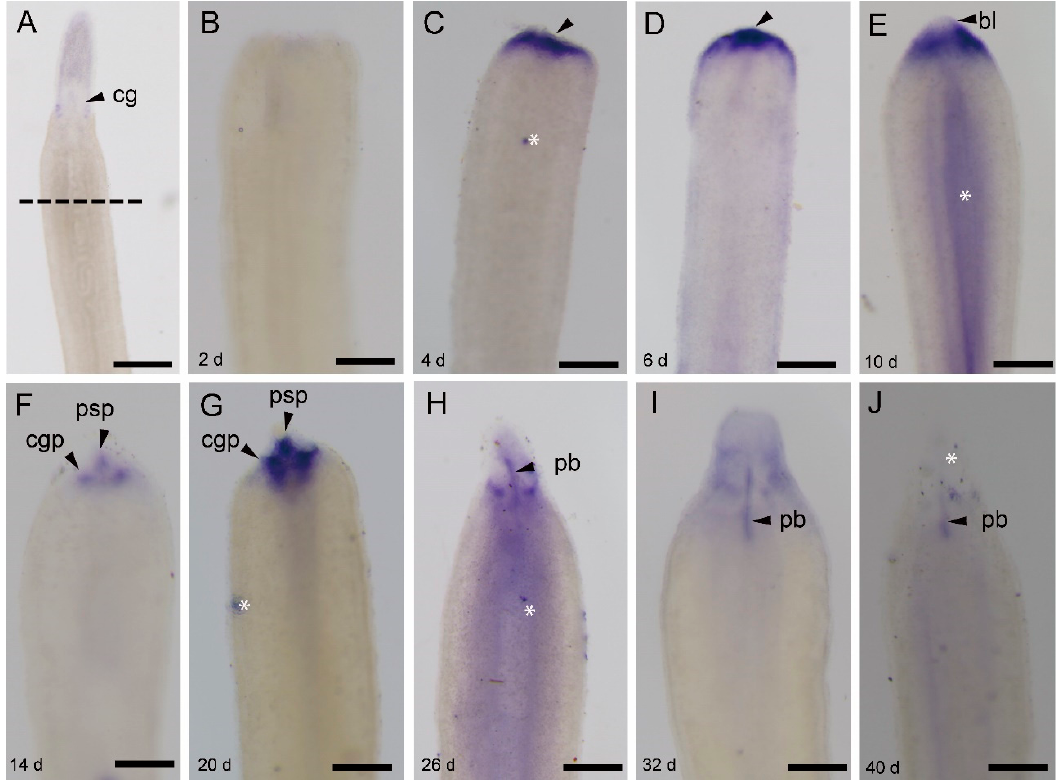
Figure 4. Ls-pcna expression during the anterior regeneration of Lineus sanguineus . ( A ) Anterior region of an adult worm (control); the dashed line indicates the site to perform amputation. ( B ) Image from 2 dpa, no expression. ( C – E ) Images from 4, 6, and 10 dpa, respectively, expressing in the blastema (arrowed). ( F , G ) Images from 14 and 20 dpa, respectively, with expression in three parts, an anterio-middle part and two posterio-lateral parts. ( H , I ) Images from 26 and 32 dpa, respectively, with expression in proboscis and around cerebral ganglia. ( J ) Image from 40 dpa, with expression only in proboscis (arrowed). Abbreviations: bl, blastema; cg, cerebral ganglion; cgp, cerebral ganglion primordium; pb, proboscis; psp, proboscis and proboscis sheath primordium. Asterisks mark nonspecific staining (see Figure S4, Supplementary Materials). Scale bars: A = 500 μ m; B–J = 200 μ m.